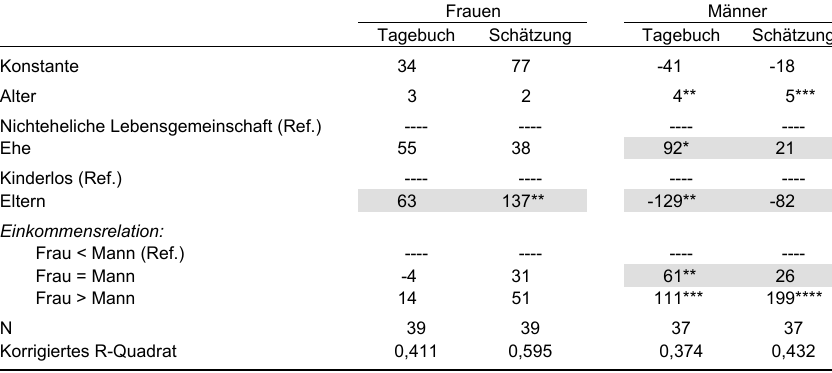
Tabelle 4: Multiple lineare Regression der Gesamtzeit für Hausarbeit – Einkommensrelation